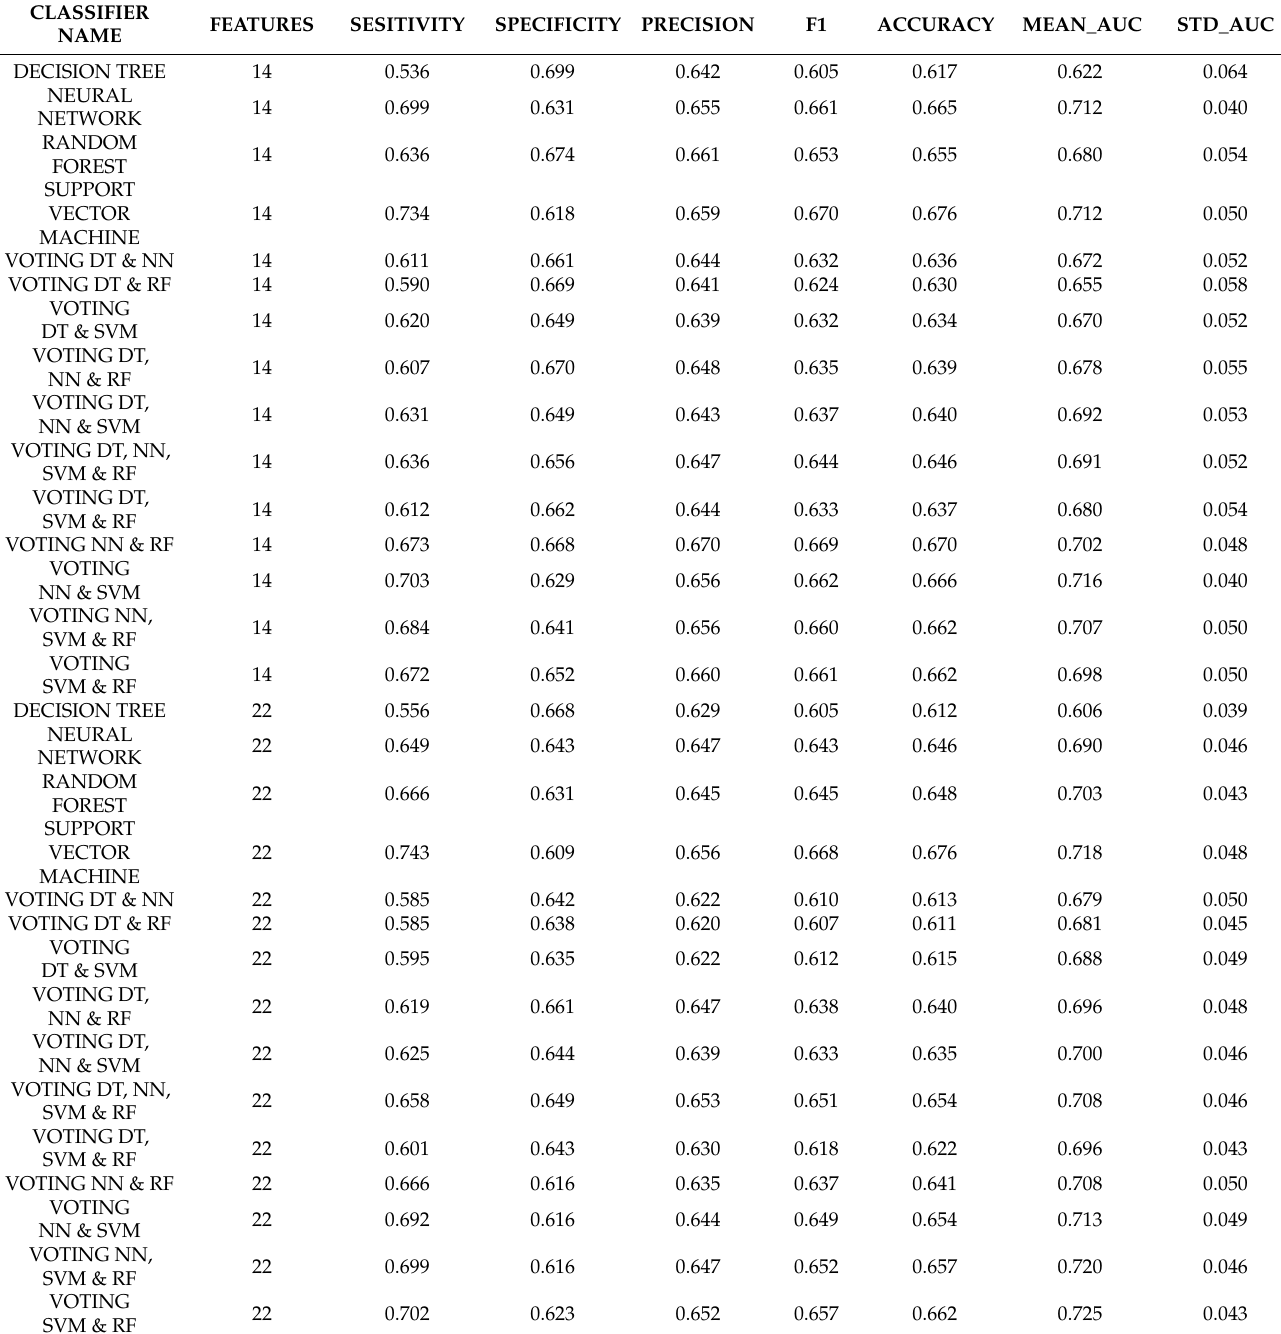
Table 2. Baseline scores for all classifiers with 14 and 22